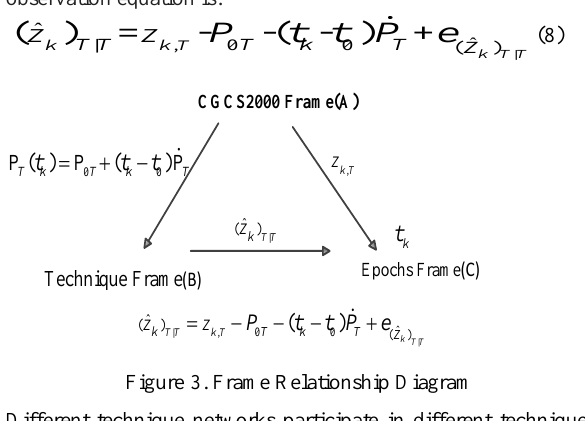
Figure 3. Frame Relationship